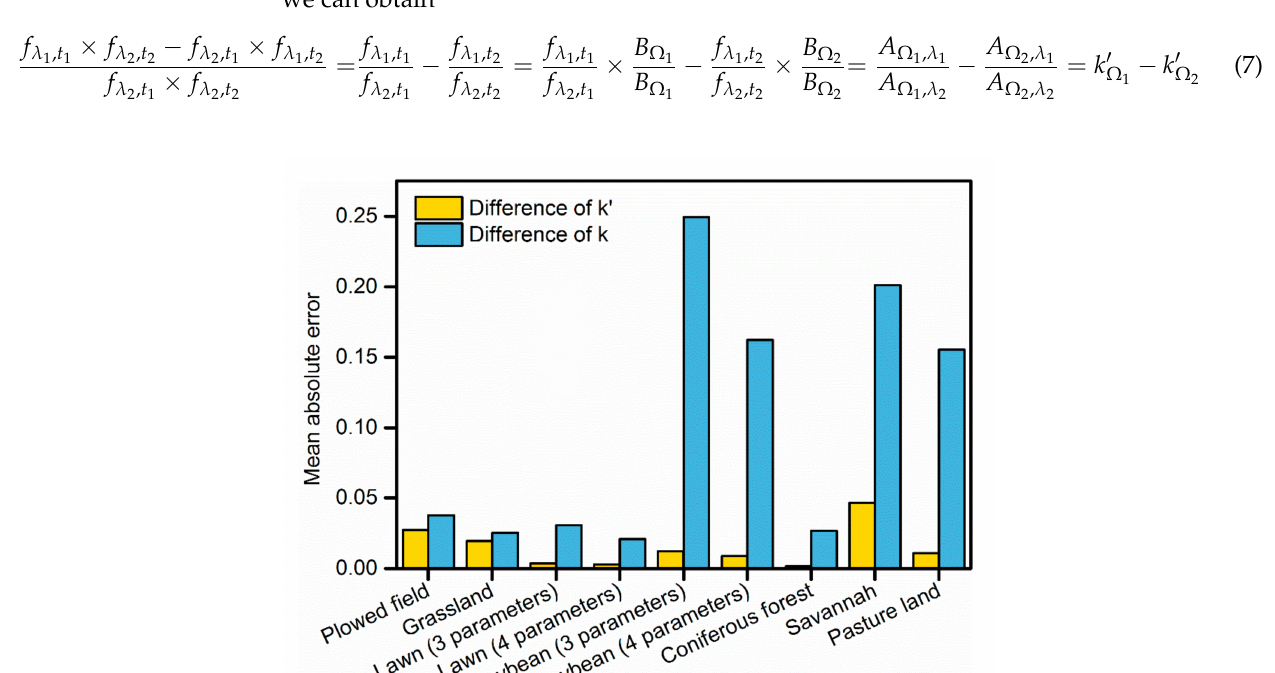
Figure 9. The mean absolute errors of k (cid:48) Ω